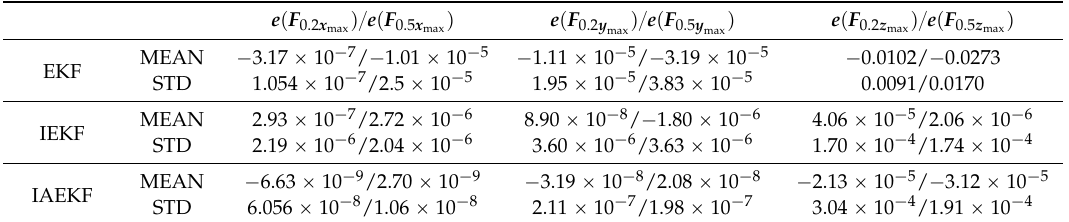
Table 5. RMSE comparison of EKF-based force estimates for two different force initialization: 0.2 and 0.5 of maximum ground